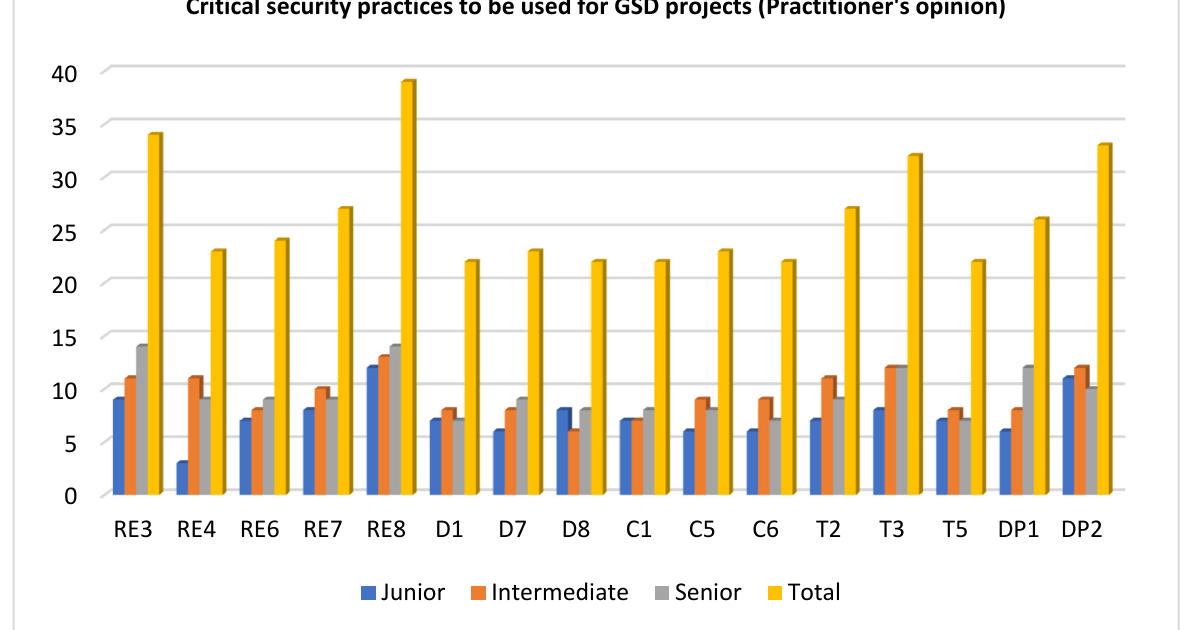
Figure 4. Important GSD security practices with high frequency .